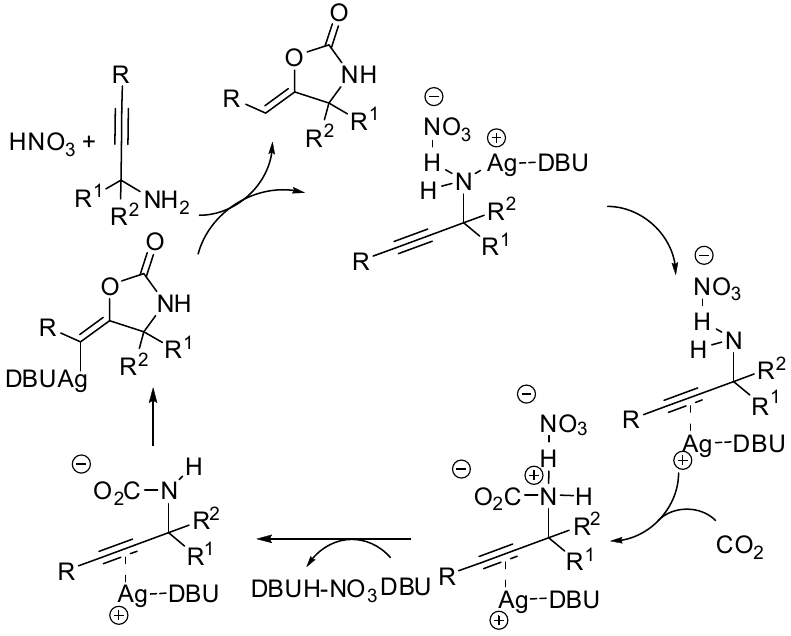
Scheme 14. Mechanism of diazabicycloundecene (DBU)-AgNO3-catalyzed CO 2 incorporation into propargylic